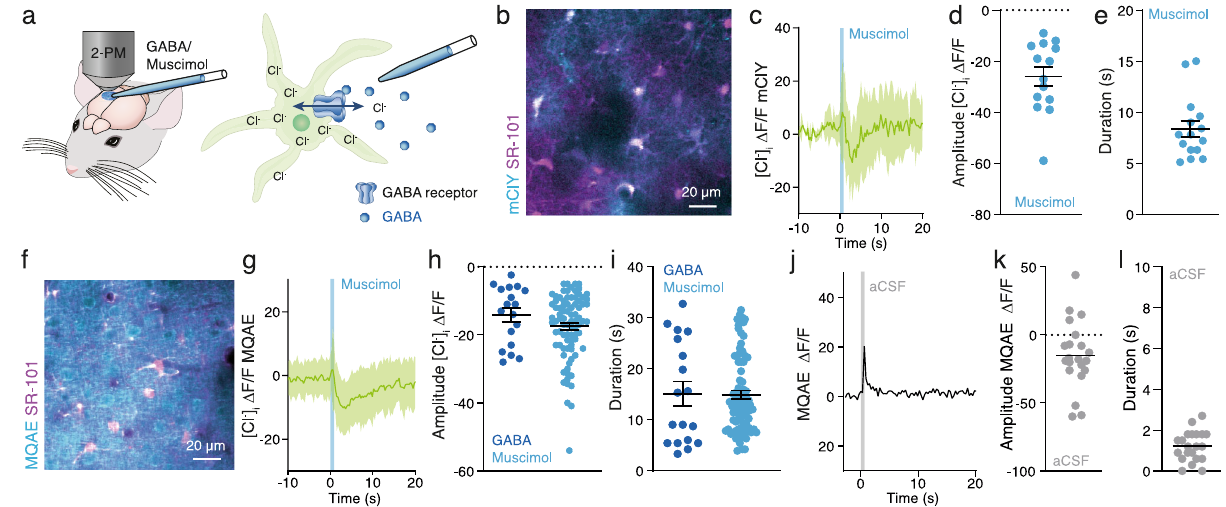
Fig. 5 | Activation of GABA A receptors in awake mice, trigger Cl − ef fl ux from astrocytes. a Astrocytic [Cl − ] i recordings using mClY or MQAE in response to injections of GABA or muscimol. b , f Representative images of the mouse cortex expressing mClY in astrocytes or loaded with MQAE and co-labelling with SR-101. c , g Astrocytic[Cl − ] i tracesduringmuscimolinjection,shadingindicates±SD. N =3 mice. d , h Decreaseofastrocytic[Cl − ] i inresponsetomuscimolorGABAinjections. Data represent mean±SD. N =4 mClY/Muscimol, 3 mice MQAE/GABA, 10 mice